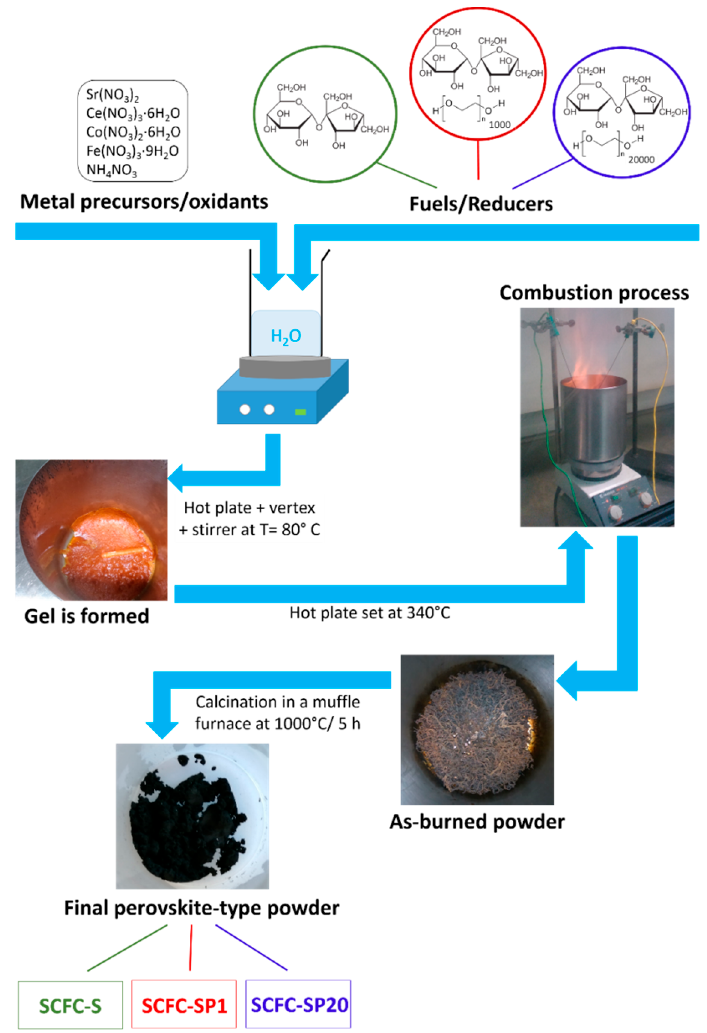
Scheme 1. Procedure used for the solution combustion synthesis of the three investigated